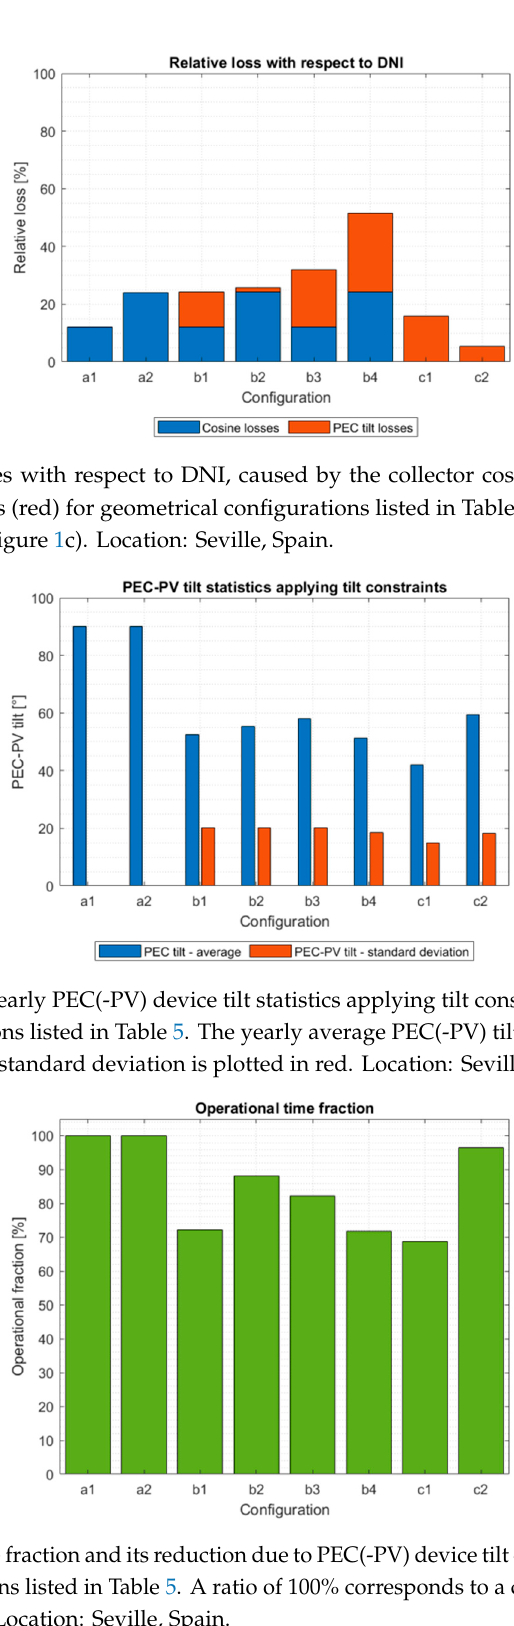
Figure 3. Summary of yearly statistics, applying tilt constraints (Figure 1c) for all geometrical configurations listed in Table 5. The monthly average is plotted in blue, while the monthly standard deviation is plotted in red. Location: Seville, Spain.